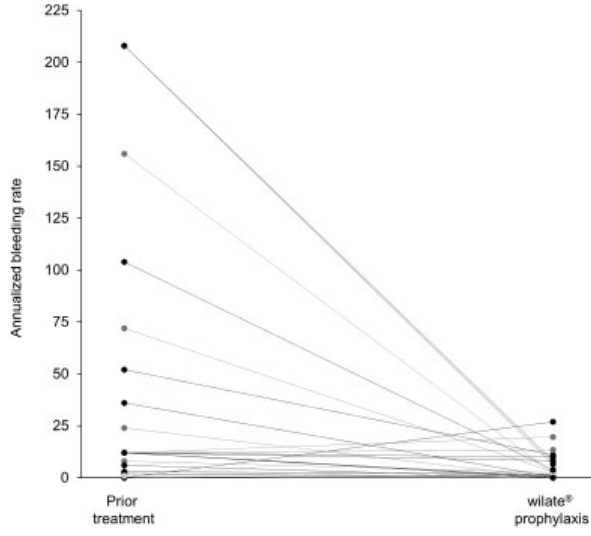
Fig. 3 Individual annualized bleeding rates in the 6 months prior to entering the study and during wilate prophylaxis ( N ¼